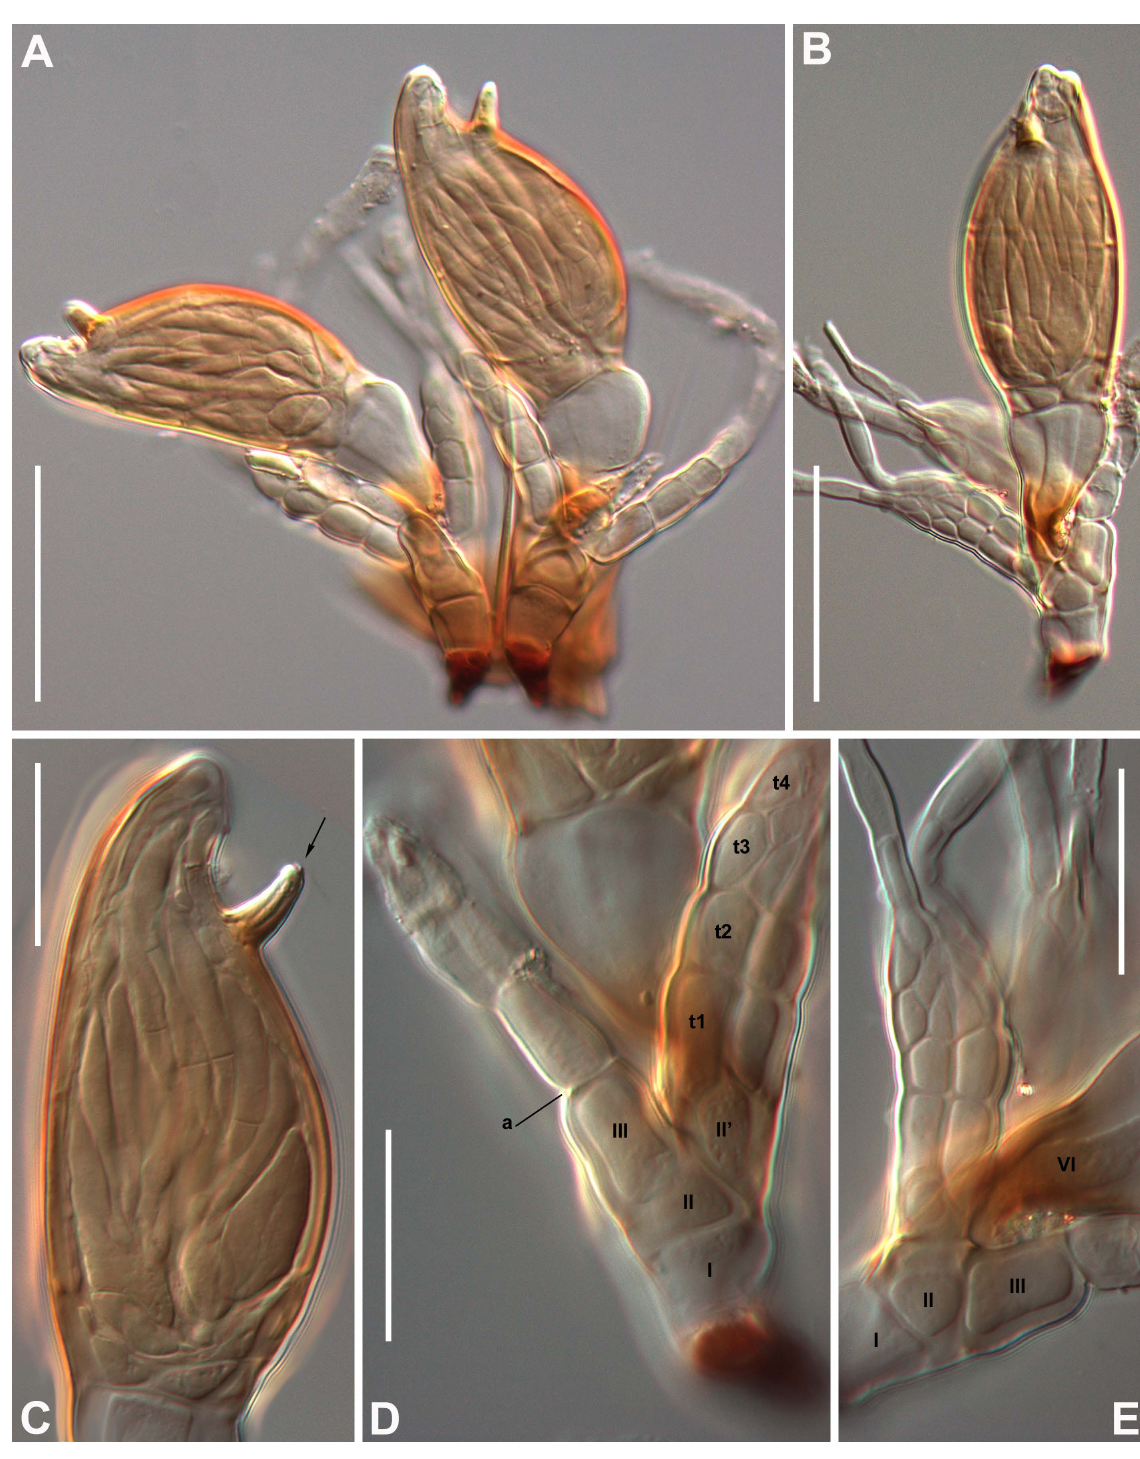
Fig. 90. Monoicomyces reboleirae Santam. sp. nov. A . A pair of mature thalli. B . Mature thallus. C . Perithecium in detail with arrow pointing to outgrowth. D . Basal area of a thallus in detail showing the primary appendage at left with labelled primary septum (a), the lower receptacle with cells I, II, and III, and the antheridium including labelled stalk (II’) and four tiers of cells (t1–4). E . Base of a thallus in detail, with labelled cells I, II, III and VI. Scale bars: A–B = 50 µm; C–E = 20 µm. Photographs from slide ZMUC C-F-124216